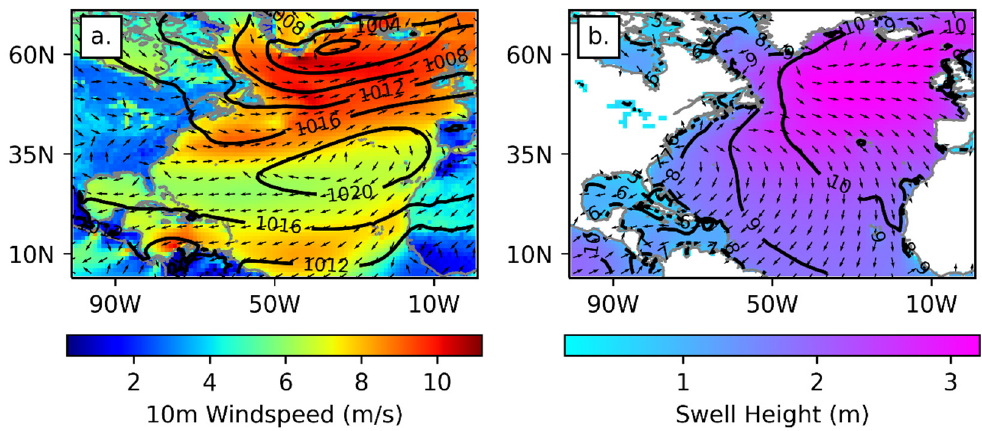
Figure 9. ( a ). NDJFMA seasonal average sea level pressure (contours, hPa), surface wind speed (shading), and direction (arrows). ( b ). NDJFMA seasonal average swell period (contours, s), height (shading), and direction (arrows). Both maps represent all days in the study period.